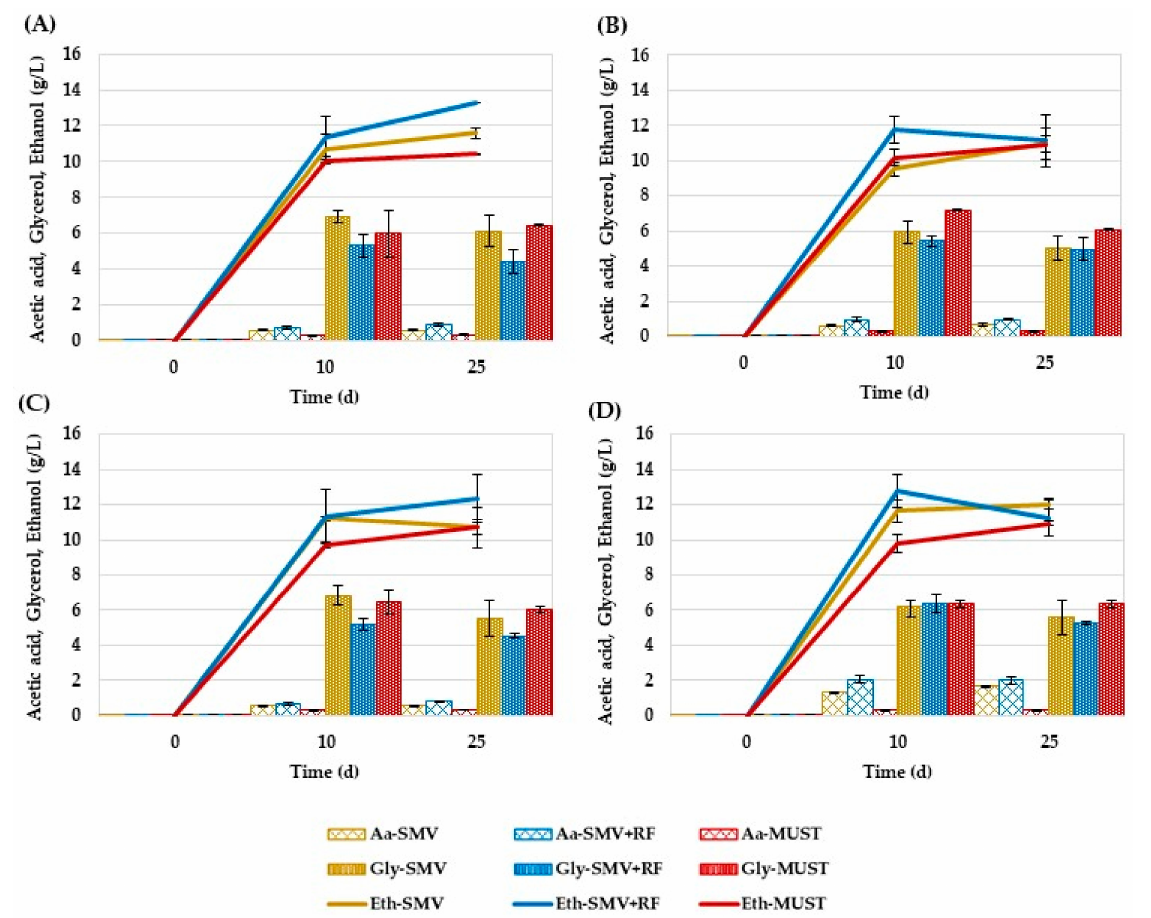
Figure 2. Amounts of acetic acid (Aa), glycerol (Gly) and ethanol (Eth) measured during the fermen- tation of the four strains. The dashed bars represent the production of acetic acid (Aa), while the full-colored ones the production of glycerol (Gly); the ethanol (Eth) production is represented by the continuous line. The results are reported as average data of three replicates and the error bars indicate the standard deviations. In each box are reported the behavior of a single strain in the three different media of growth (SMV = dark yellow, SMV+RF = blue line, MUST = red line), as follow: ( A ) EC1118; ( B ) IOC18-2007; ( C ) LS2; ( D ) AWRI